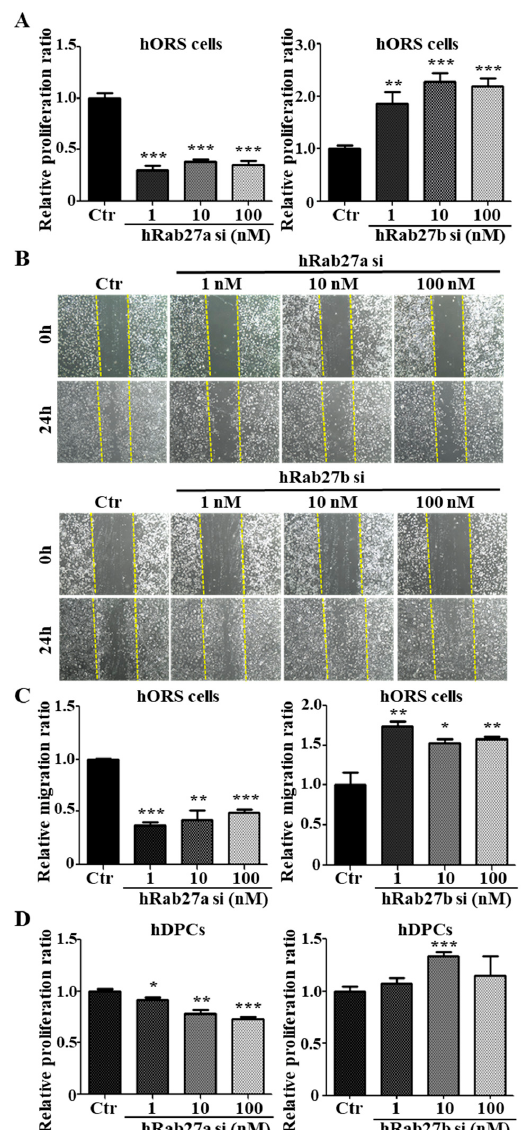
Figure 4. Rab27a and Rab27b have opposite effects on the proliferation and migration of hORS cells and hDPCs. ( A ) The knockdown of hRab27a decreased the proliferation of hORS cells by up to 70% compared with the control. On the other hand, knockdown of hRab27b increased the proliferation of hORS cells by up to 230% compared with the control. ( B ) The knockdown of Rab27a in hORS cells for 24 h decreased the migration of hORS cells, whereas knockdown of Rab27b for 24 h increased the migration of hORS cells. ( C ) The migration assay results were quantified. ( D ) Knockdown of hRab27a decreased the proliferation of hDPCs in a concentration-dependent manner. On the other hand, knockdown of hRab27b increased the proliferation of hDPCs and showed the highest effect at a concentration of 10 nM. hDPCs; human dermal papilla cells, hORS cells; human outer root sheath cells, Ctr; control, si; siRNA. * p < 0.05, ** p < 0.01, *** p < 0.001 using Student’s t test. Three independent experiments were conducted for all data points. All error bars indicate S.E.M.